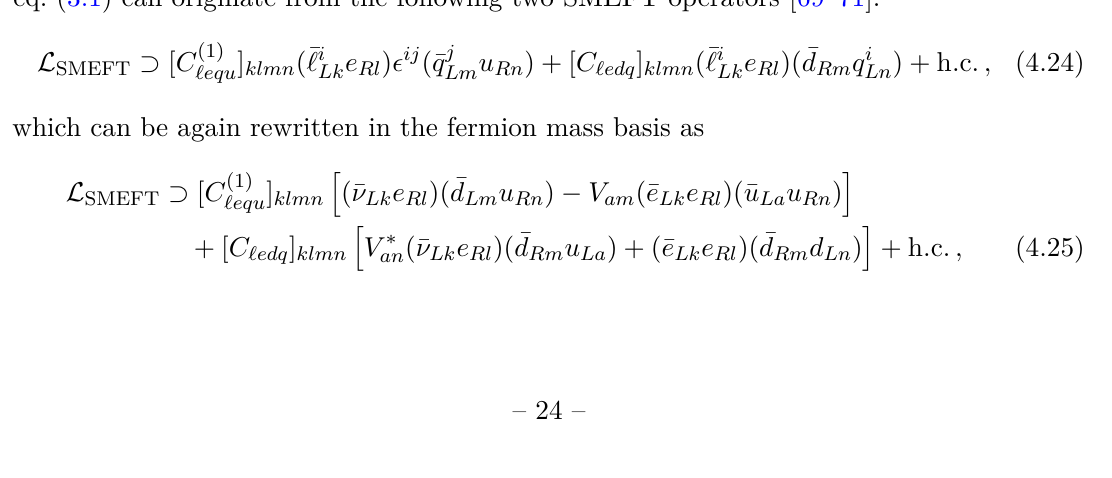
] 3311 + V us V cs [ (cid:15) ] 3321 , T ( S ) T ( S ) are purely imaginary 2 , 3